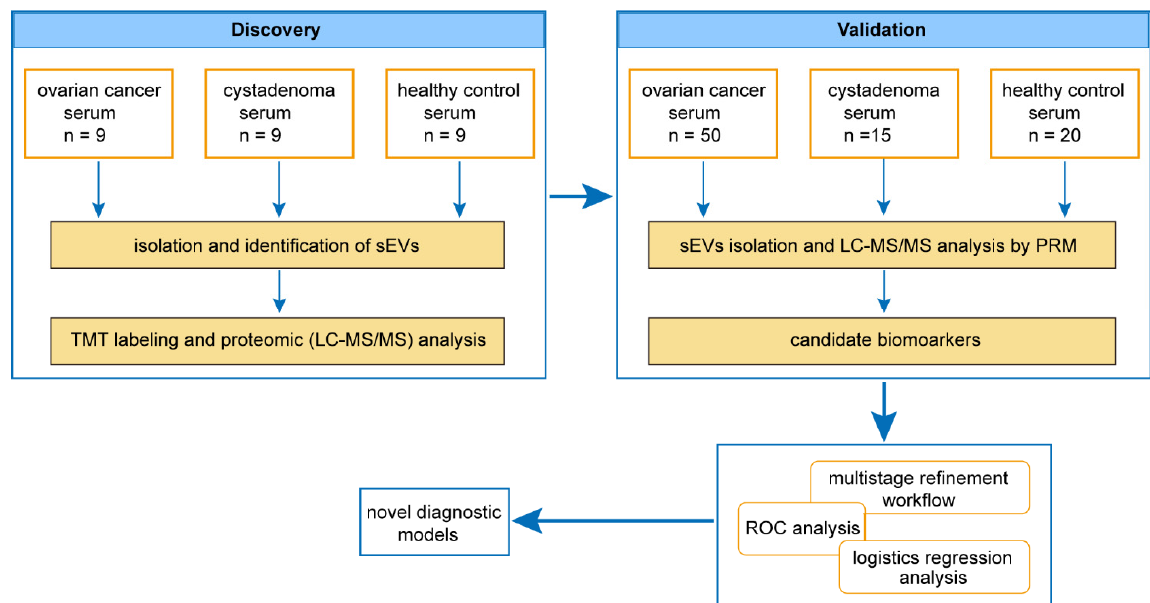
Figure 1. The overall design and flow chart to obtain protein profiles of serum sEVs for ovarian cancer and establish novel diagnostic models. In the discovery study, nine patients with ovarian cancer or cystadenoma and nine healthy controls were enrolled. Isolated sEVs were subjected to TMT labeling LC-MS/MS analysis. PRM was used to further assess candidate biomarkers in a validation cohort composed of 50 patients with ovarian cancer, 15 patients with cystadenoma, and 20 healthy controls. Through ROC analyses, logistic regression analyses and a multistage refinement, novel diagnostic models were constructed for the purpose of ovarian cancer screening in a population or differential diagnosis between ovarian cancer and cystadenoma.